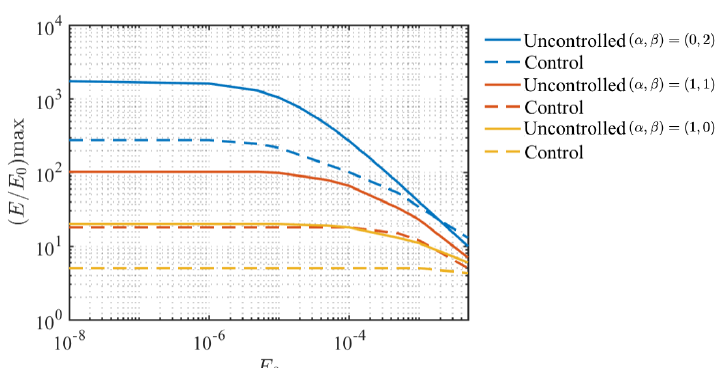
Figure 13. A comparison of maximum amplified transient energy density ( E / E 0 ) max of a range of amplitude of initial optimal disturbances between uncontrolled (solid lines) and controlled (dashed lines)